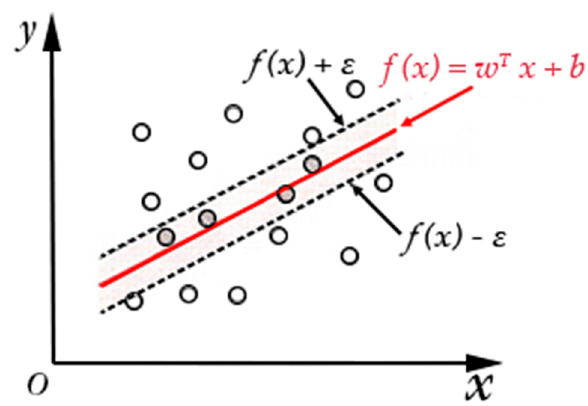
Figure 2. Principle of Support Vector Regression (SVR).